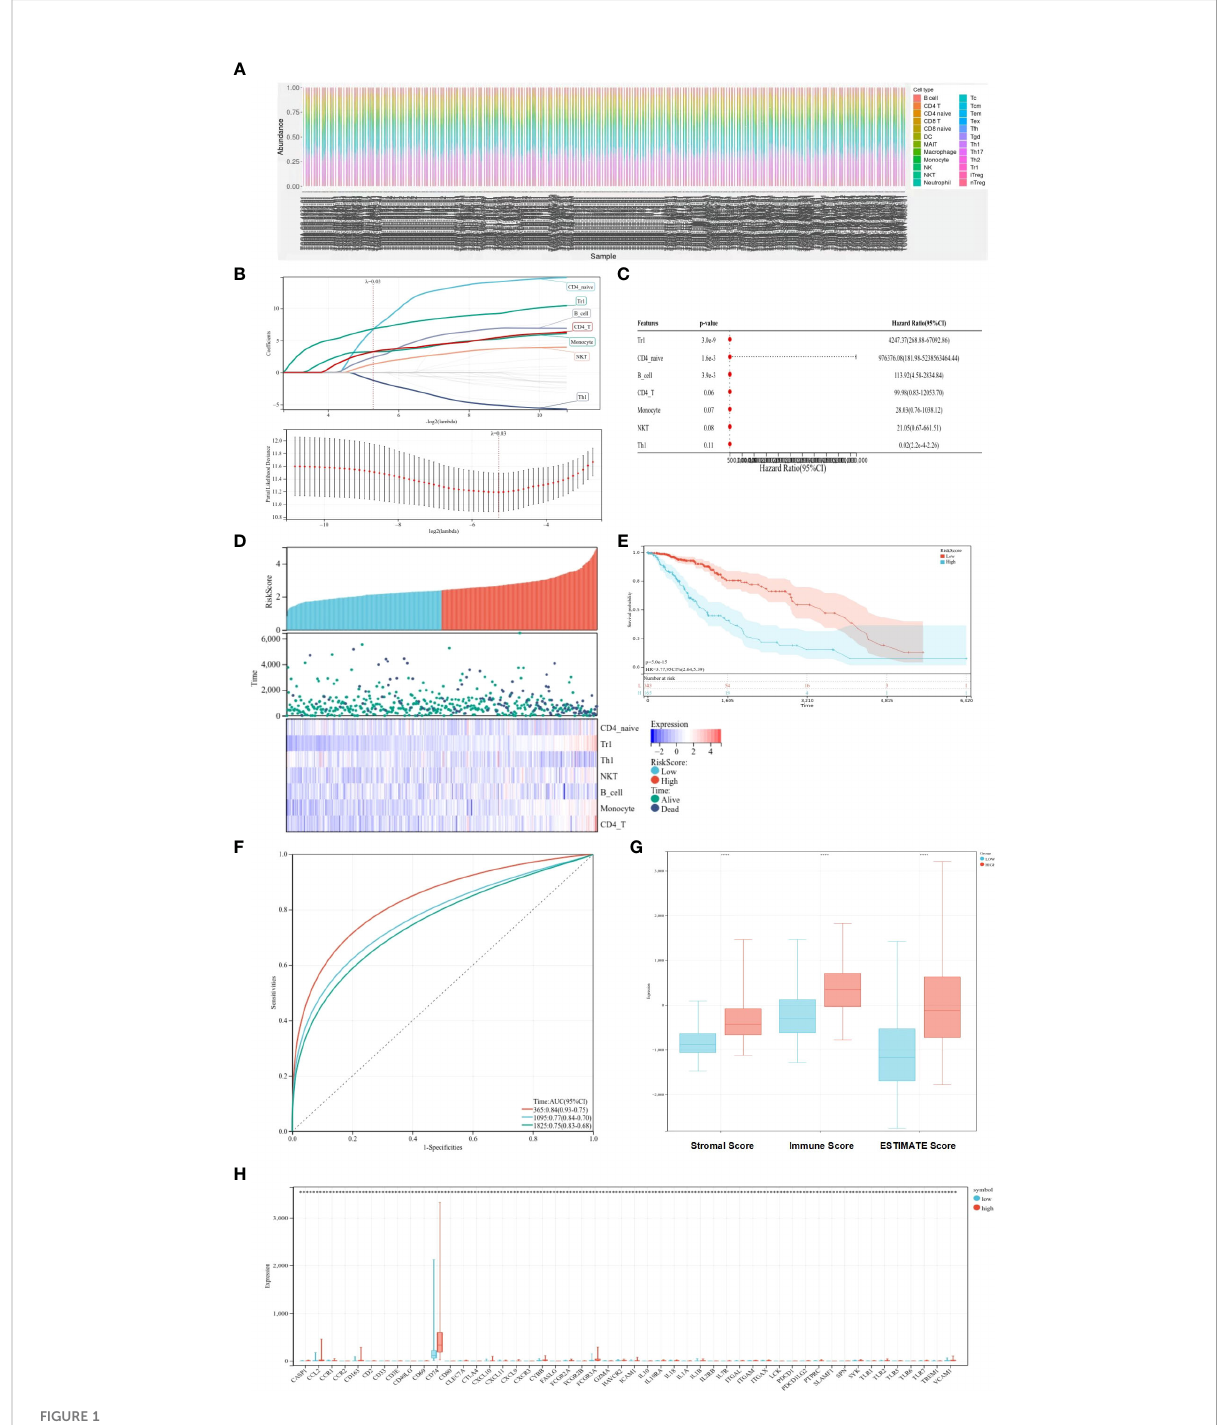
FIGURE 1 Prognostic value of immune cells for predicting OS. (A) Distribution of immune cell types. (B) LASSO coef fi cient pro fi les. (C) Univariate and multifactorial Cox analyses used to identify OS-related immune cells. (D) Heat map of survival status and expression in different risk score groups. (E) Kaplan – Meier survival curves showing survival in the different risk score groups. (F) ROC curve showing the predictive value of TCRS for 1-, 3-, and 5-year OS. (G) Box plots showing differences in the stromal score, immune score, and ESTIMATE score between different risk score groups. (H) Expression of immune genes in different risk-score groups compared with low group. * p < 0.05; ** p < 0.01; *** p < 0.001; **** p <